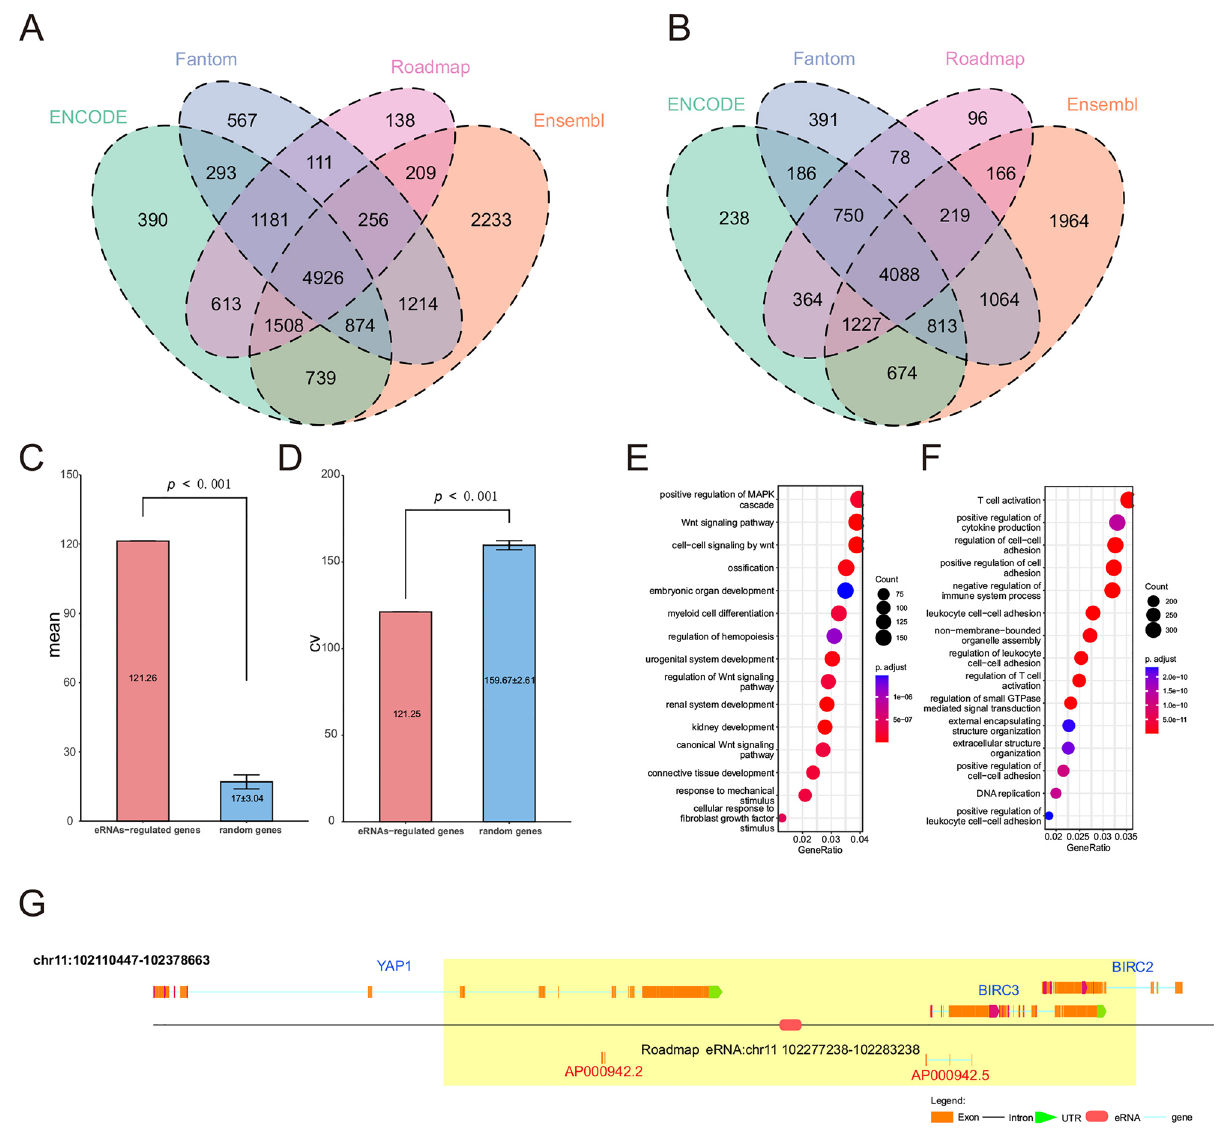
the mean ( C ) and CV ( D ) of gene expression between eRRGs and random genes. Bubble plots show the results of functional enrichment analyses on eRNAs-regulated PCGs ( E ) and eRNAs-regulated lncRNAs ( F ). The color of the bubble represents the values of FDR and the size reflects the overlapped gene numbers between each GO term and query gene set. ( G ) The gene structure diagrams show the position of genes and eRNA in chromosome 11: 102277238–102283238. The PCGs are shown in blue and lncRNAs are shown in red. The yellow rectangle denotes the contact domains of